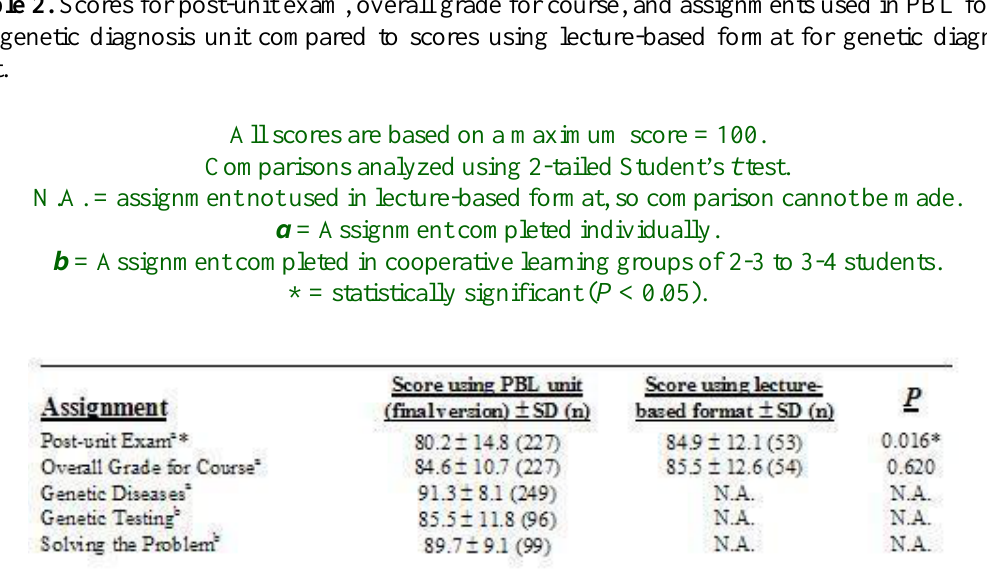
Table 2. Scores for post-unit exam, overall grade for course, and assignments used in PBL format for genetic diagnosis unit compared to scores using lecture-based format for genetic diagnosis